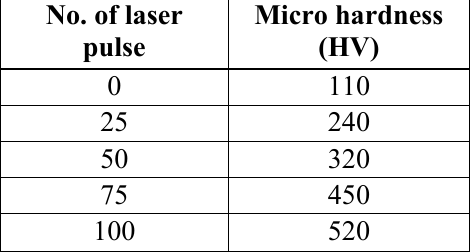
Table 3: Relation between No. of laser pulse and micro hardness.